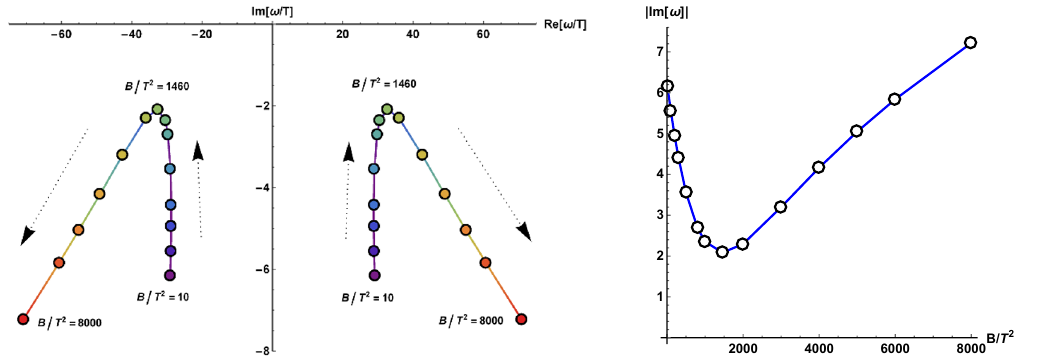
Figure 18 . QNMs motion in the complex plane for the same parameters of (cid:12)gure 17. The dynamics is produced by dialing the dimensionless magnetic (cid:12)eld B=T 2 , while keeping other parameters (cid:12)xed.